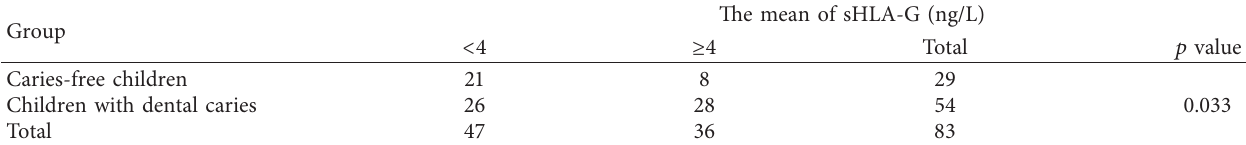
Table 1: Comparison of salivary sHLA-G level between caries-free children and children with dental caries (the chi-squared test).